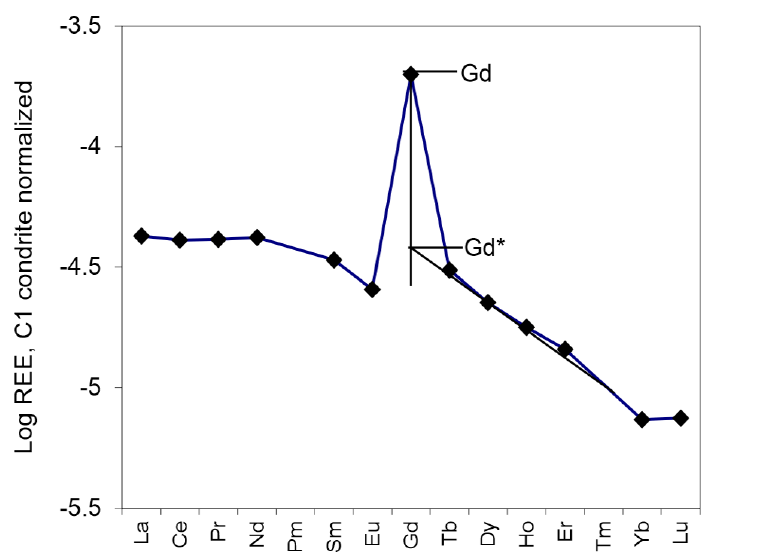
Figure 3. Determination of the Gd anomaly exemplified by a pattern of high-salinity brine from the Dead Sea. Gd is exaggerated in order to illustrate the procedure of Gd ∗